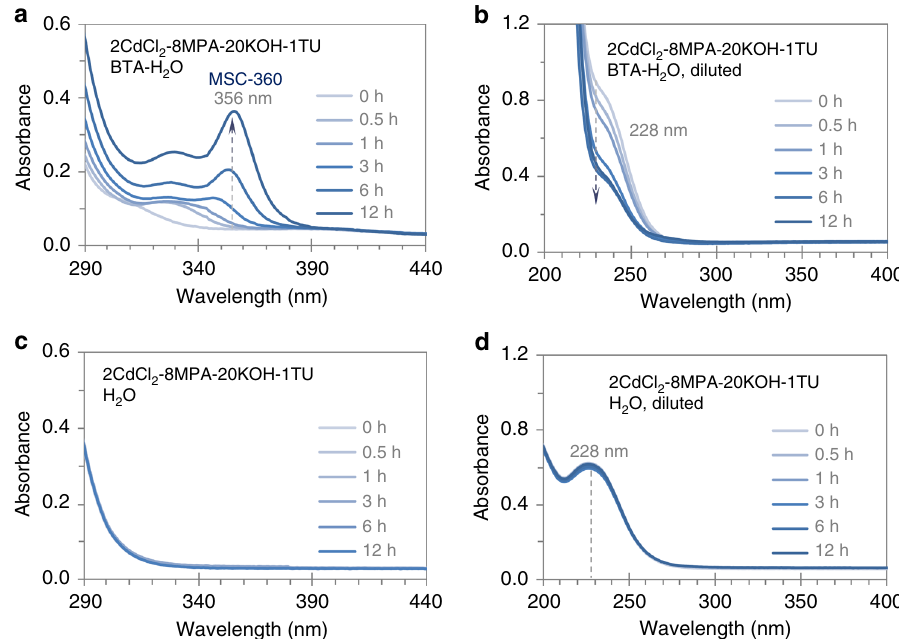
Fig. 1 Absorption spectra of one mixture of CdCl 2 , MPA, KOH, and TU in two solvents. They are a mixture of BTA and H 2 O with equal volumes ( a , b ), and H 2 O ( c , d ). The spectra are collected at the various periods indicated ( a , c ); right after each measurement, an aliquot (50 μ L) is diluted in 3.0 mL of water ( b , d ). The spectra are offset to have similar absorbance at 440 ( a , c ) or 400 nm ( b , d ). The dashed arrows ( a , b ) and line ( d ) signify the positions indicated. Evidently, the presence of BTA is a prerequisite for the room-temperature evolution of CdS